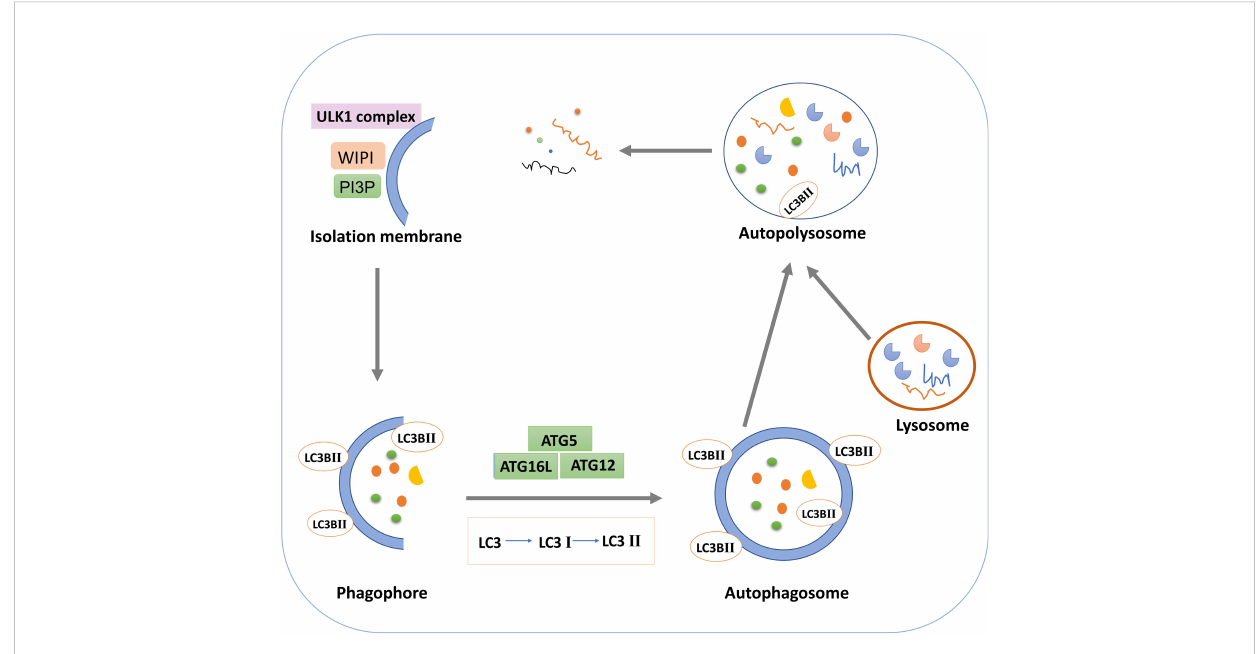
FIGURE 1 Schematic diagram of